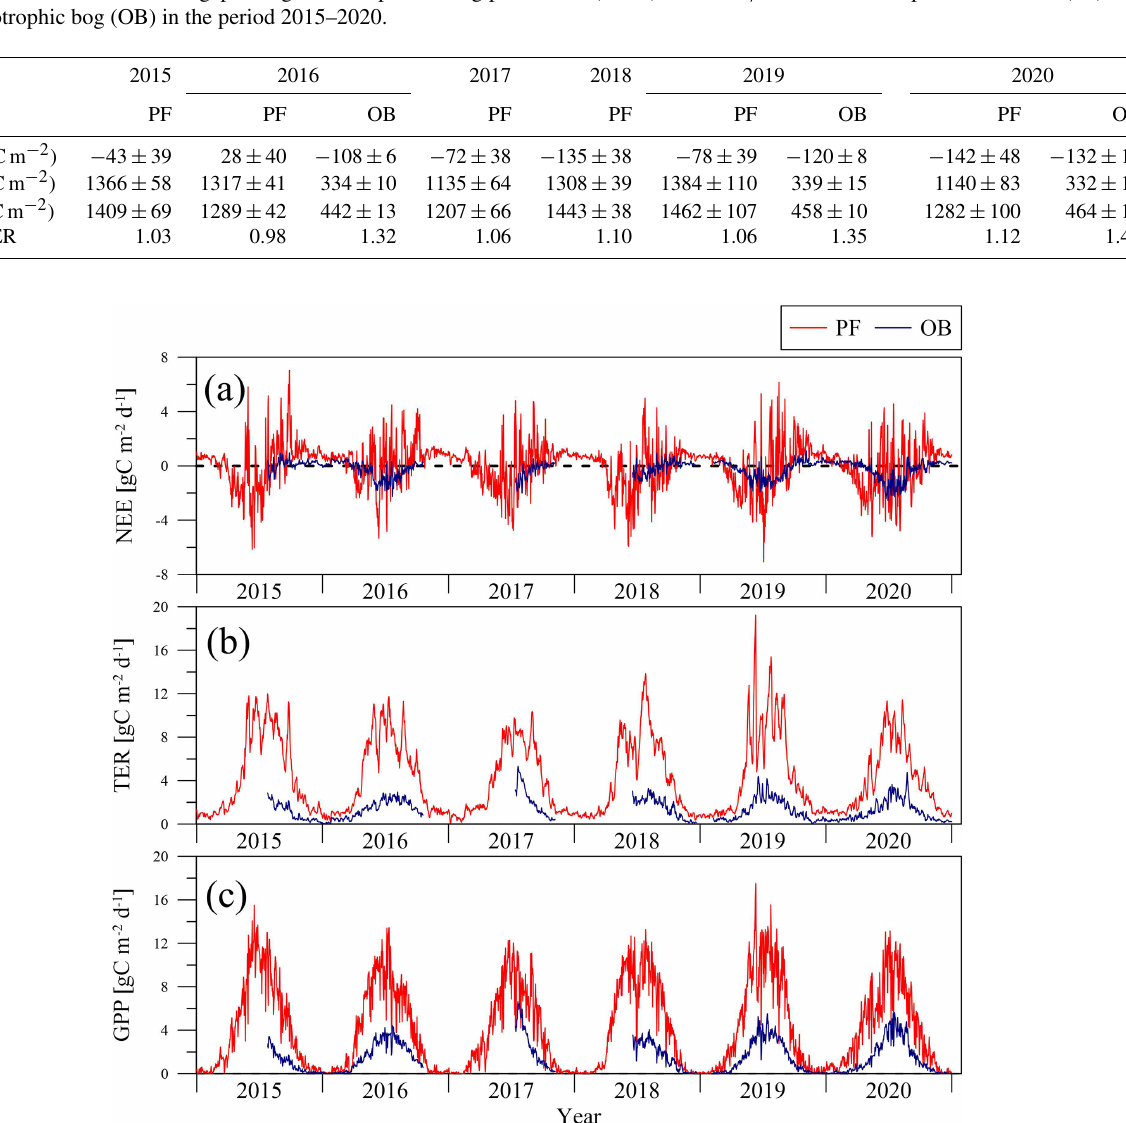
Figure 3. Seasonal variation in the net ecosystem exchange (NEE) (a) , total ecosystem respiration (TER) (b) , and gross primary produc- tion (GPP) (c) at the paludified forest (PF) and ombrotrophic bog (OB) sites in the period